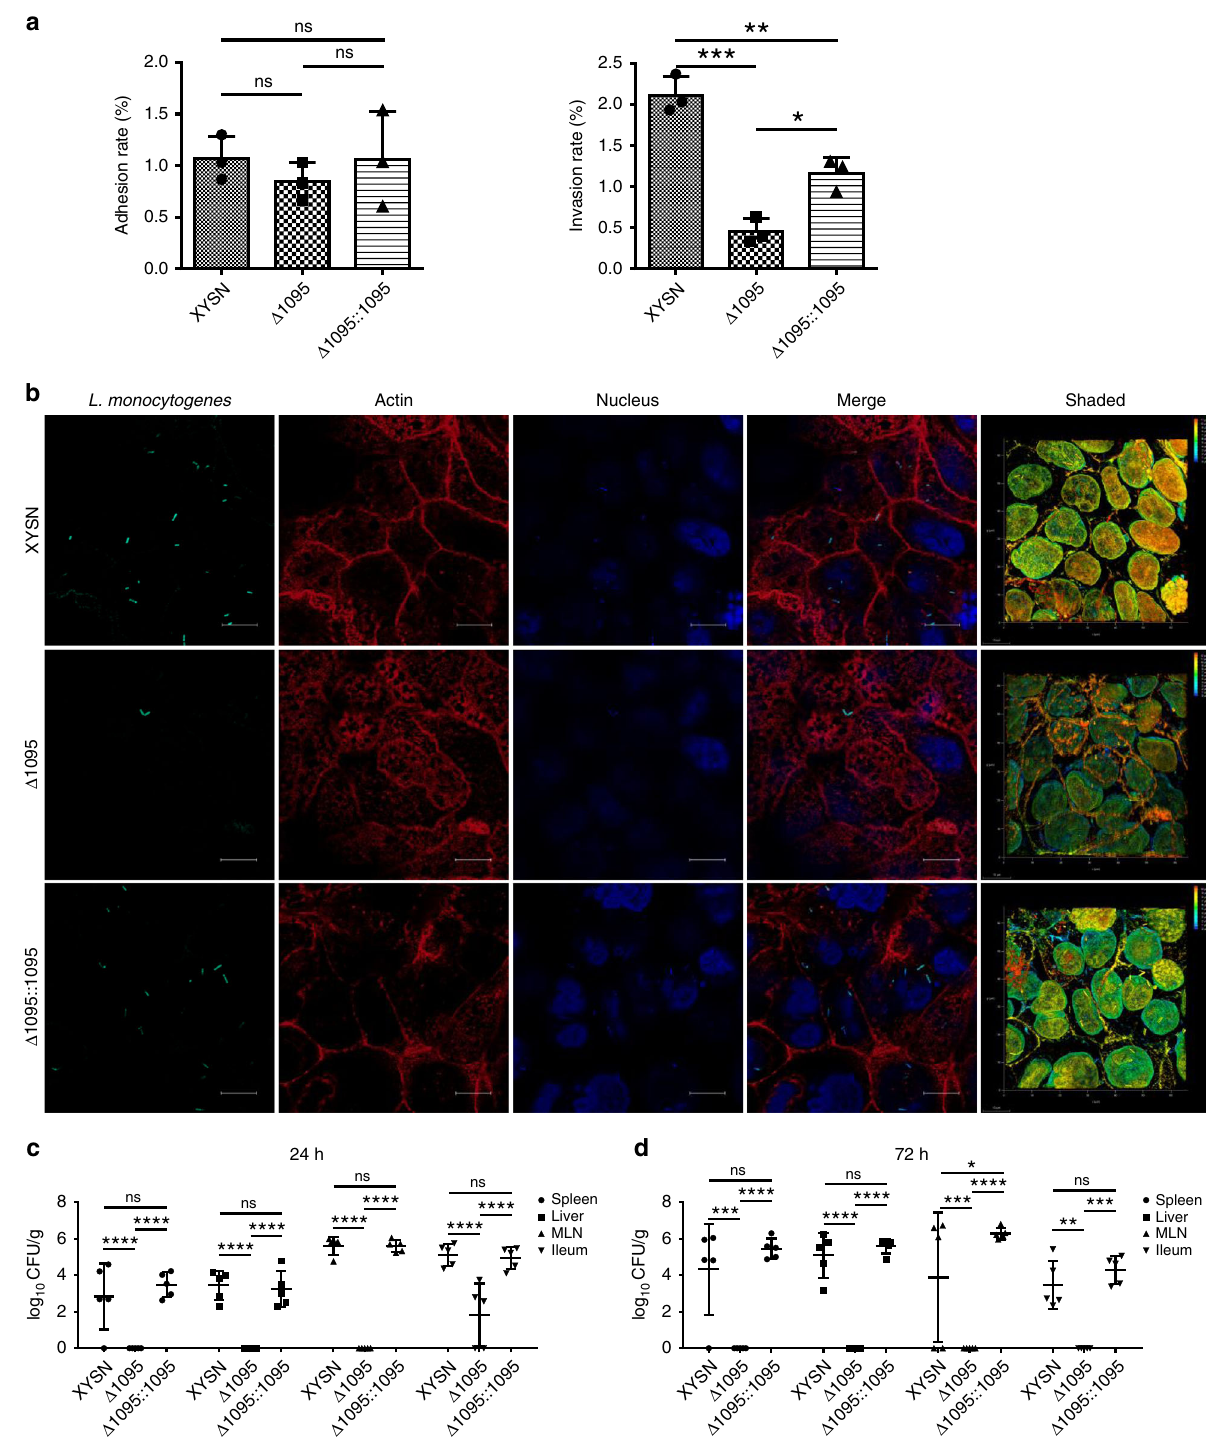
Fig. 4 Comparative invasive capacities of XYSN and its isogenic WTA mutants. a Adhesion and invasion rates, and ( b ) confocal images of GFP-expressing strains XYSN, Δ 1095, Δ 1095::1095 in Caco-2 BBe cells at 15 min post internalization. The actin cytoskeleton was stained by phalloidin (red) and DNA was stained by DAPI (blue) following fi xation and permeabilization of the sample. The fl uorescent samples were analyzed by confocal microscopy. Magni fi cation of all images: ×1000. Scale bars, 10 μ m. Error bars represent SD, n = 3 independent experiments. Statistical analyses were carried out by Tukey's multiple comparisons test: * P < 0.05, ** P < 0.01, *** P < 0.001, ns: no signi fi cance. c , d Comparative organ colonization properties of XYSN and its isogenic WTA mutants ( Δ 1095 and Δ 1095::1095). Experiments were performed at 24 and 72 h post infection. Each dot represents an organ from one infected mouse. The log CFUs/g represents the mean of fi ve mice per group. Statistical analyses were carried out by Tukey's multiple comparisons test: * P < 0.05, ** P < 0.01, *** P < 0.001, **** P < 0.0001, ns: no signi fi cance. Error bars represent SD, data represent ( c ) and ( d ) two independent